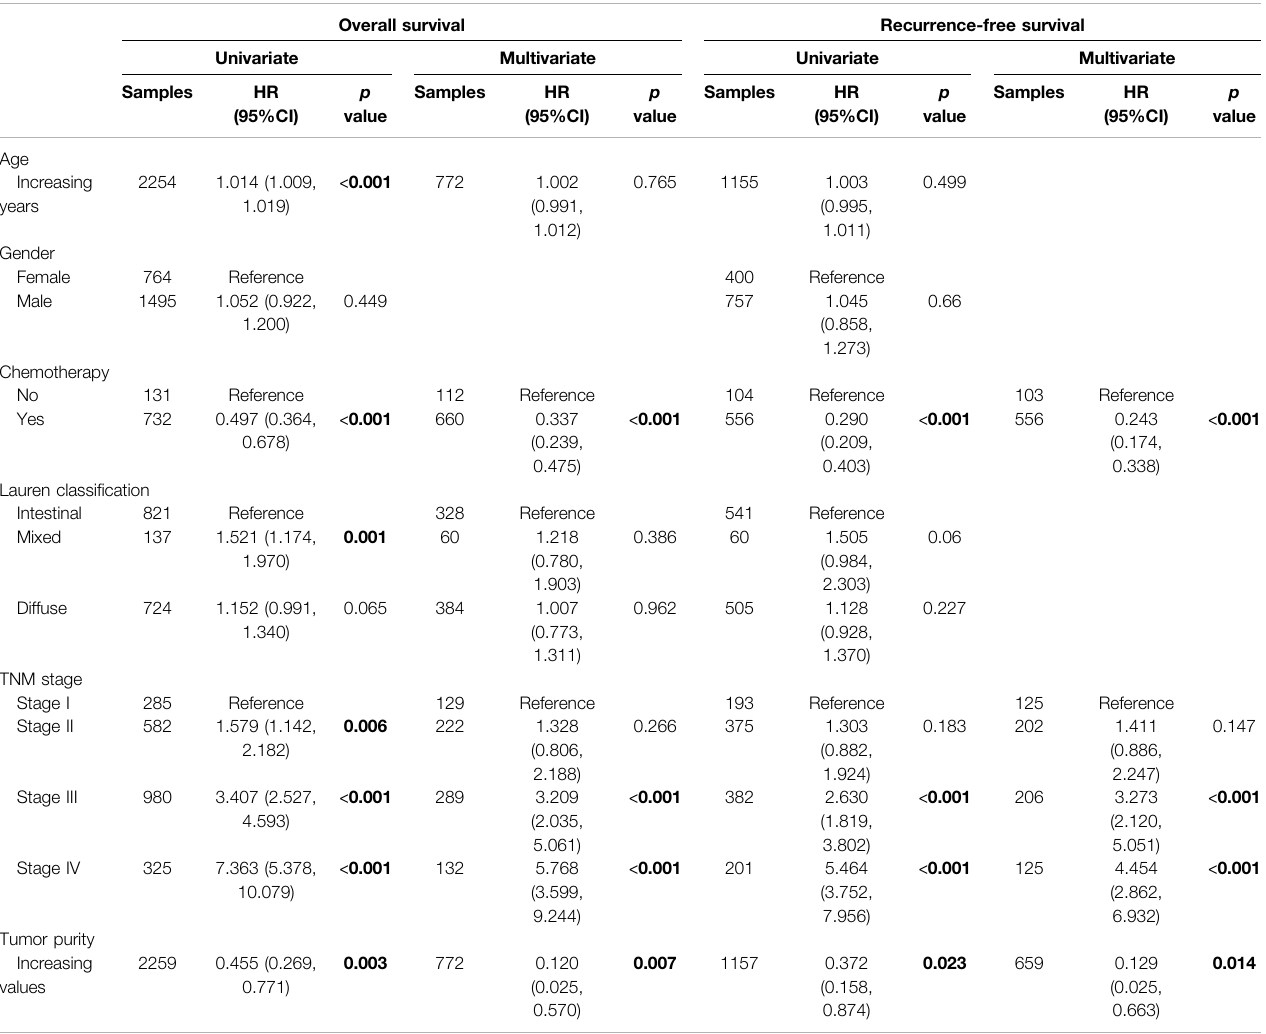
TABLE 1 | Univariate and multivariate cox analyses for tumor purity in gastric